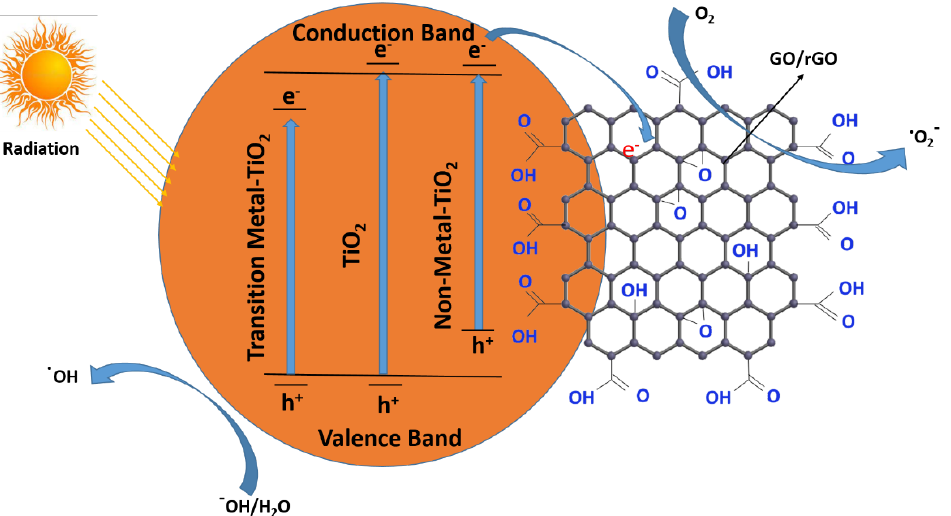
Figure 11. A sketch of the radical generation through semiconductor-doped GO or rGO binary com- posite, showing the valance band and conduction band.